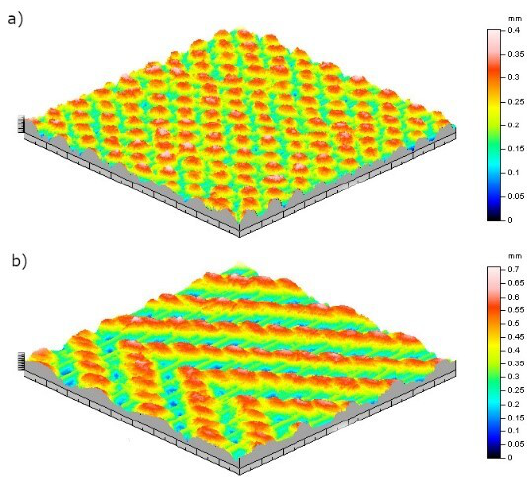
Figure 5. ( a ) Plain and ( b ) twill 2 / 2 structures visualization through profilometry method